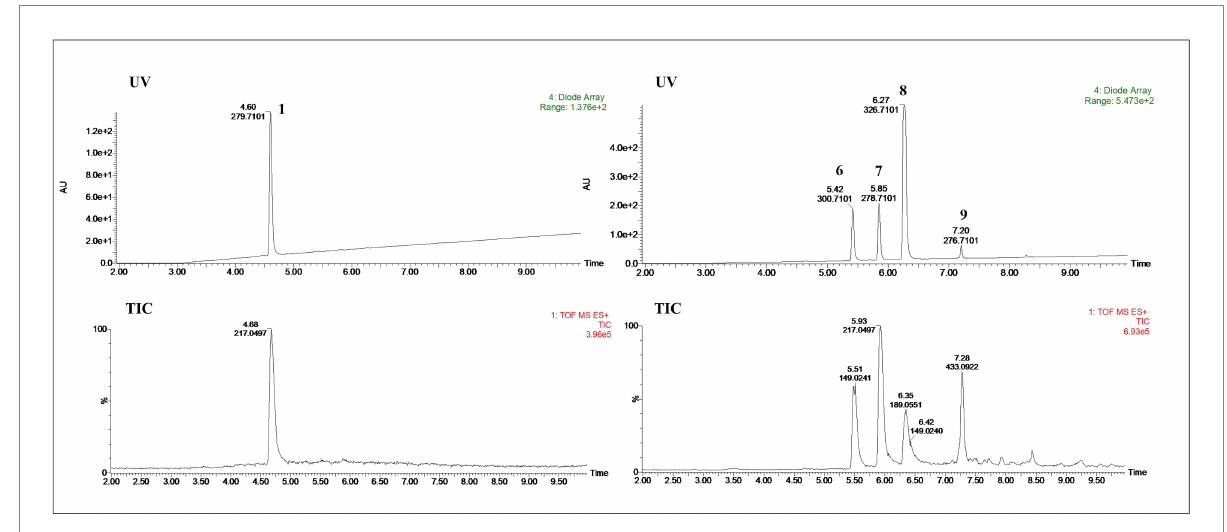
FIGURE 4 The UPLC-Q-TOF-MS UV and total ion chromatogram (TIC) of compound ( 1 ) and degraded products ( 6 – 9 ) in modified Mosher’s